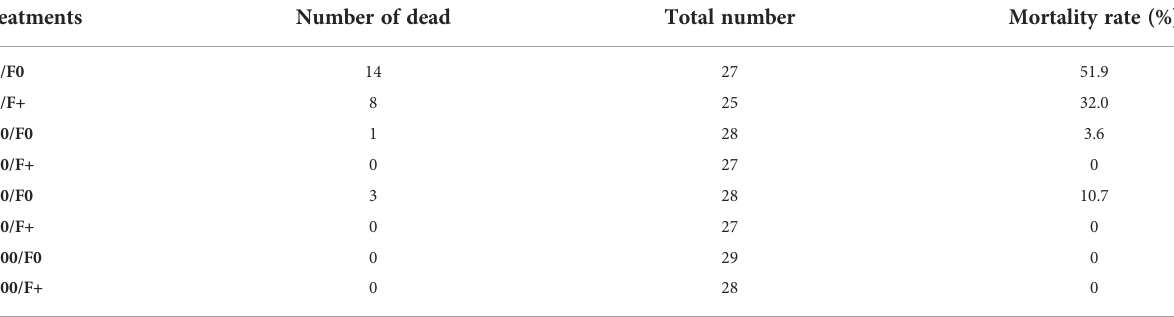
TABLE 3 Mortality rate of downy oaks saplings with different drought and fertilizer application treatments (investigated after 1.5 years drought, in June 2017).